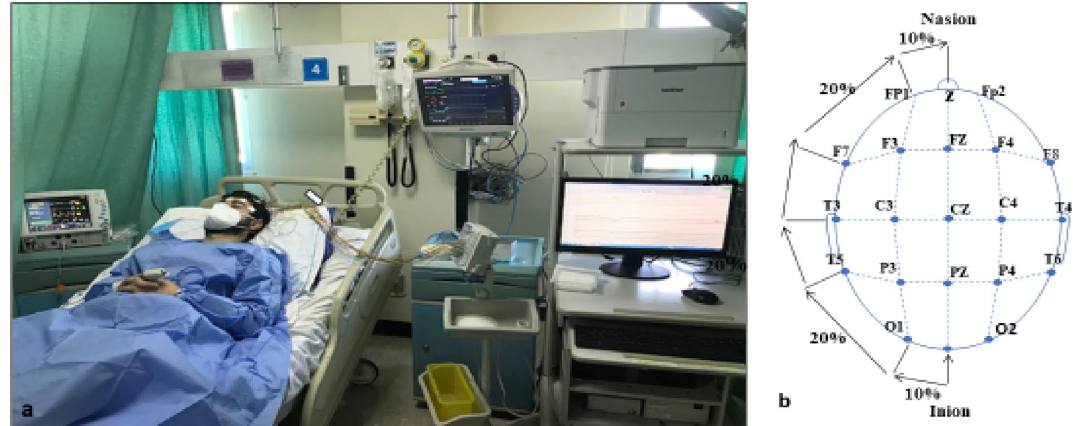
Figure 1. ( a ) Volunteer undergoing EEG recording and monitoring, with face mask; ( b ) Electrode placement diagram used in our study, 10–20